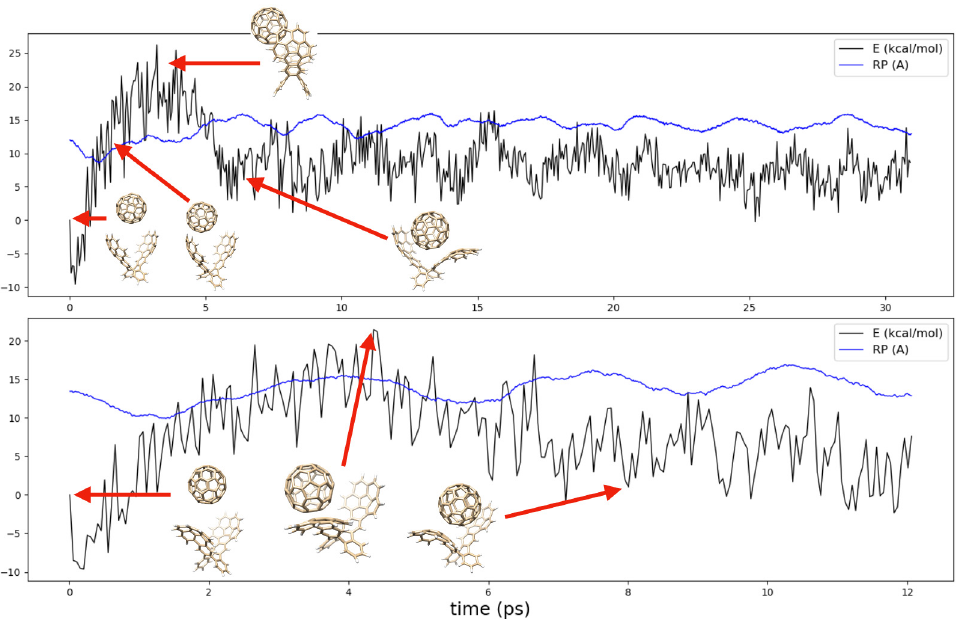
Figure 3. Dynamics of the catcher– C 60 van der Waals